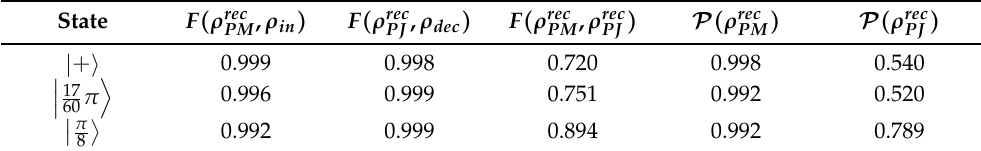
Table 1. Comparison between theoretical and reconstructed density matrices. F ( ρ rec F ( ρ rec , ρ dec ) : fidelities between reconstructed density matrices ρ rec PJ terparts ρ in ( dec ) in the PM (PJ) case; F ( ρ rec unprotected states; and P ( ρ rec case, respectively.